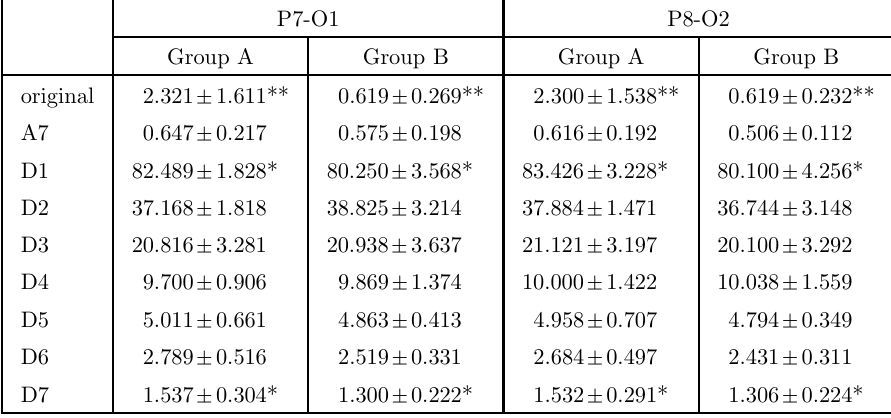
Table 3. The results of dominant frequencies for signals from channels P7-O1 and P8-O2 in studied groups (Mann-Whitney test) P7-O1 P8-O2 Group A Group B Group A Group B original 2.321 ± 1.611** 0.619 ± 0.269** 2.300 ± 1.538** 0.619 ± 0.232** A7 0.647 ± 0.217 0.575 ± 0.198 0.616 ± 0.192 0.506 ± 0.112 82.489 ± 1.828* 80.250 ± 3.568* 83.426 ± 3.228* 80.100 ± 4.256* 38.825 ±